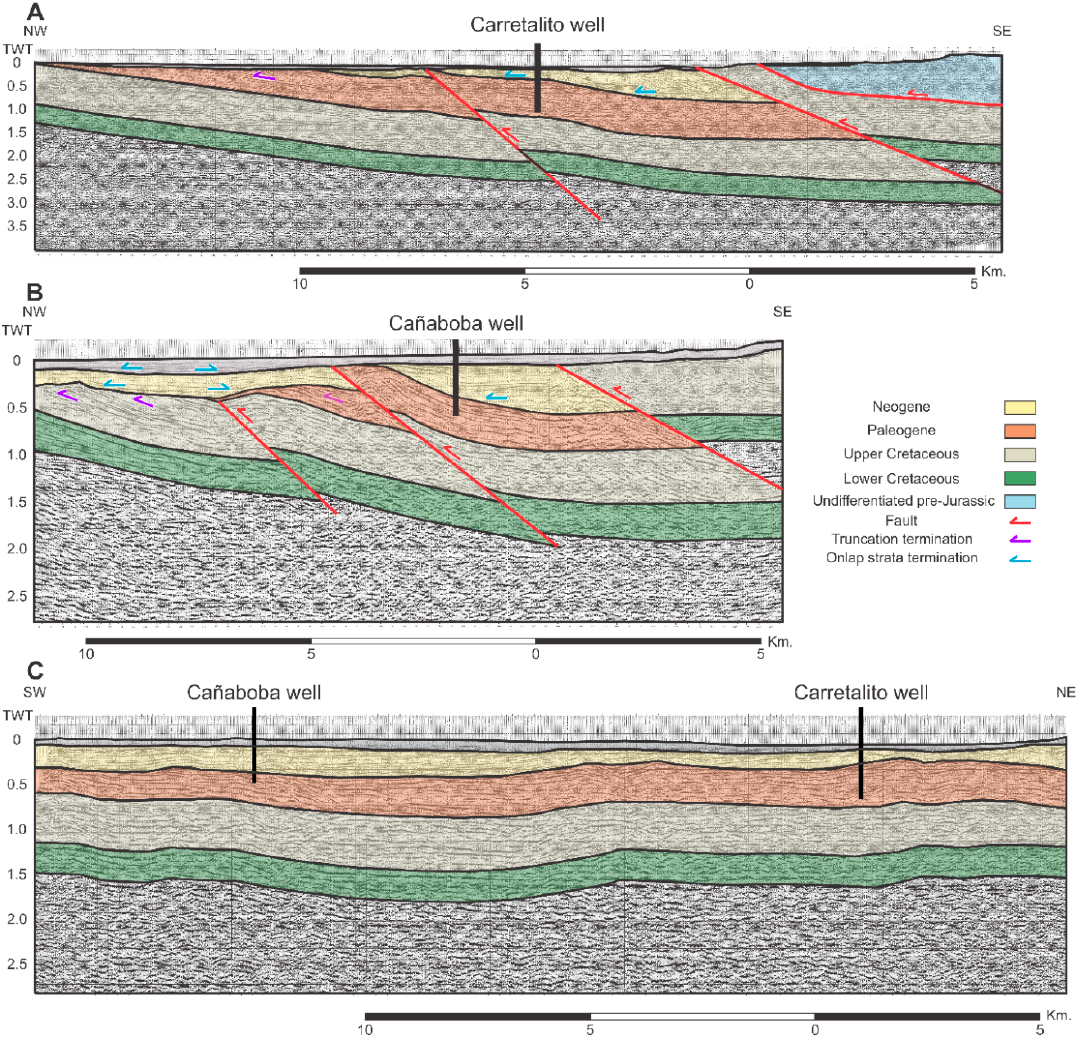
Figure 2. Interpreted 2D seismic lines in two-way time (TWT) with location of ANH-CARRETALITO-1 and ANH-CAÑABOBA-1 wells. Seismic lines ( A ) CV-1989–2200; ( B ) CV-1989–1885; and ( C ) CV-1959–1100. Line locations are shown in Figure 1A.